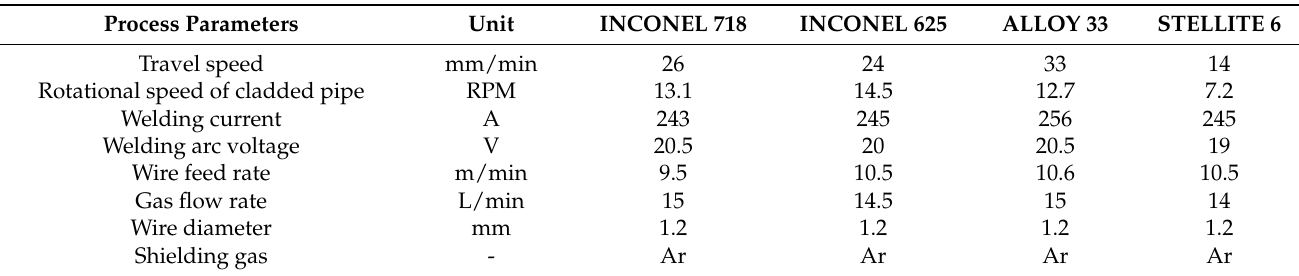
Table 1. CMT cladding process parameters.